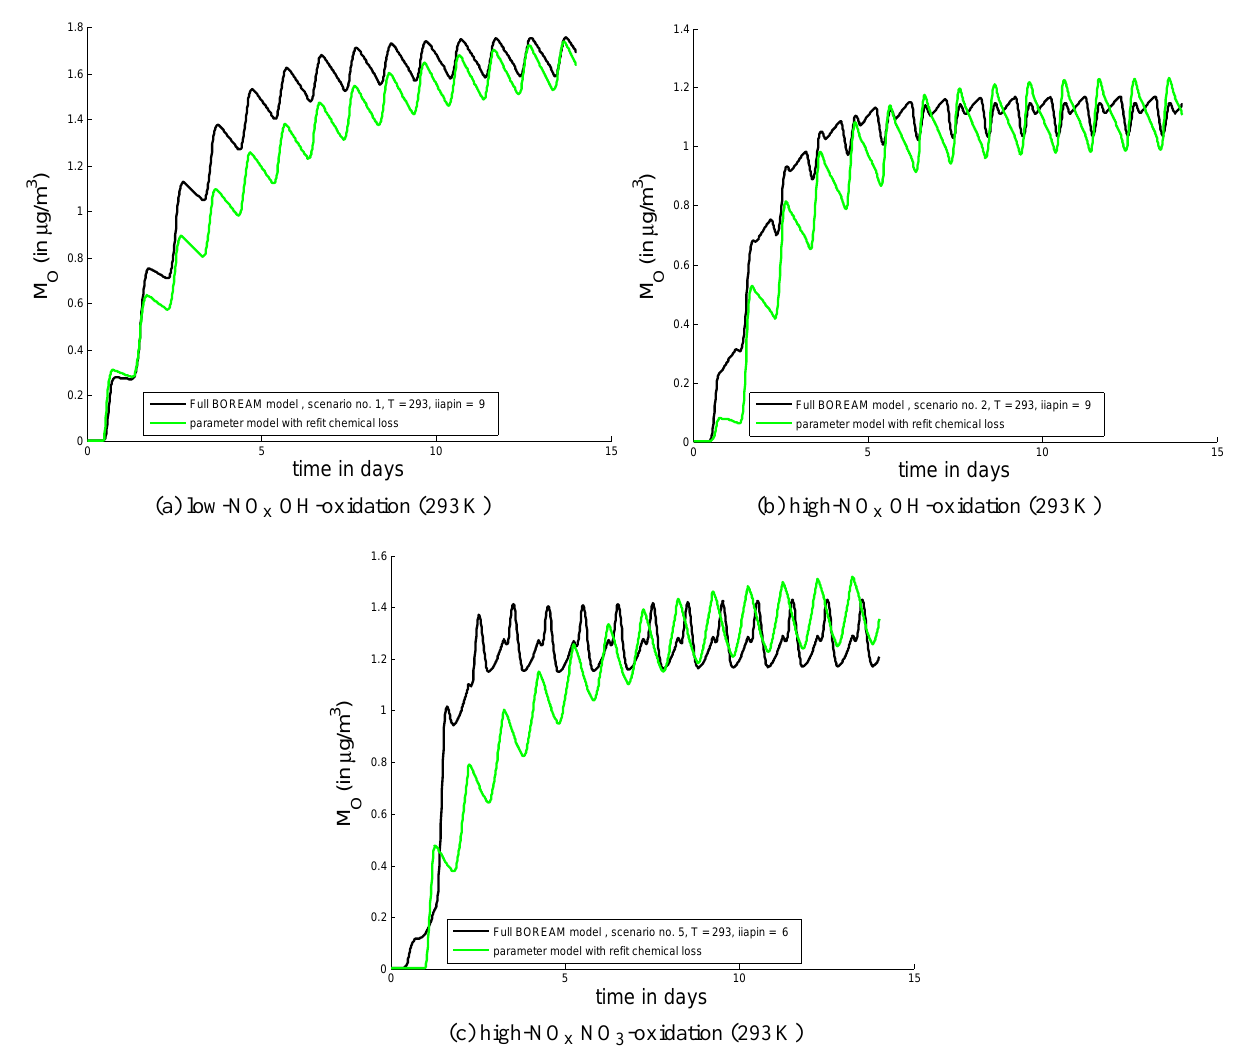
their maximum in this range is about 3–4 Fig. 5: Fitted (red) and full model (black) net equilibrium SOA mass yields as functions of the organic aerosol mass loading M O , for the low-NO x OH-oxidation scenario. The seven curves are obtained at temperatures ranging from 0 to 30 ◦ C, by steps of 5 ◦ C, the highest temperature corresponding to the lowest curve.